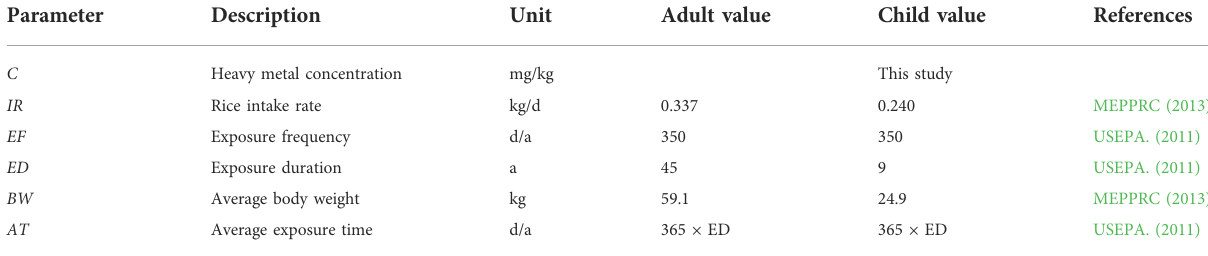
TABLE 1 Parameter values of health risk assessment model.